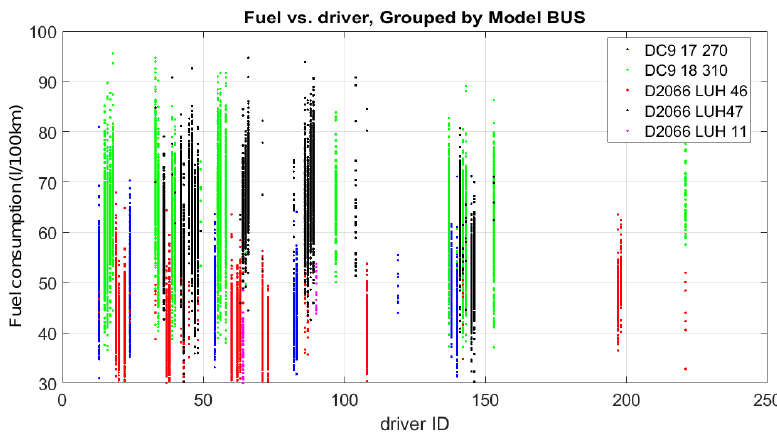
Figure 5. Influence of driver and BUS Model on fuel consumption.